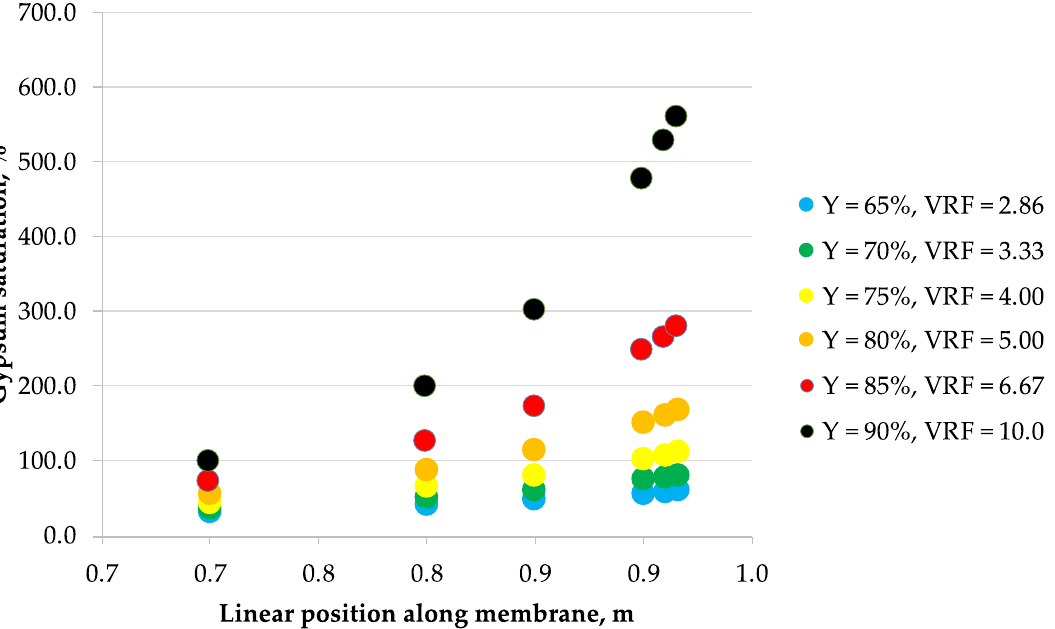
Figure 5. Saturation vs. position along the membrane for mine water B (33.2 g / L as Cl − , 0.937 g / L as SO 42 − , 19.5 g / L as Na + , 0.990 g / L as Mg 2 + , 0.771 g / L as Ca 2 + ) and NFX nanofiltration membrane.